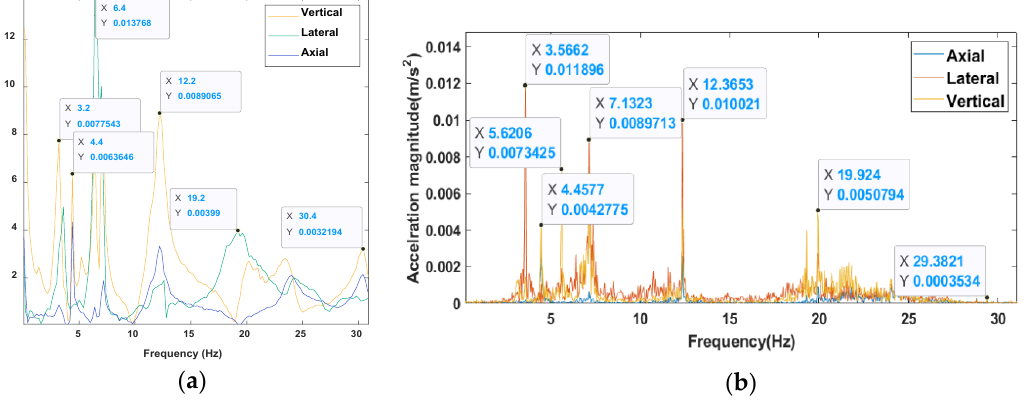
Figure 22. Experimental results, natural frequency response of the fully-extended manipulator under axial excitation at the end-effector obtained from ( a ) accelerometers data and ( b ) the VRU data. Table 5. Comparison of Natural Frequencies Obtained from Experimental and Finite Element Anal- ysis.